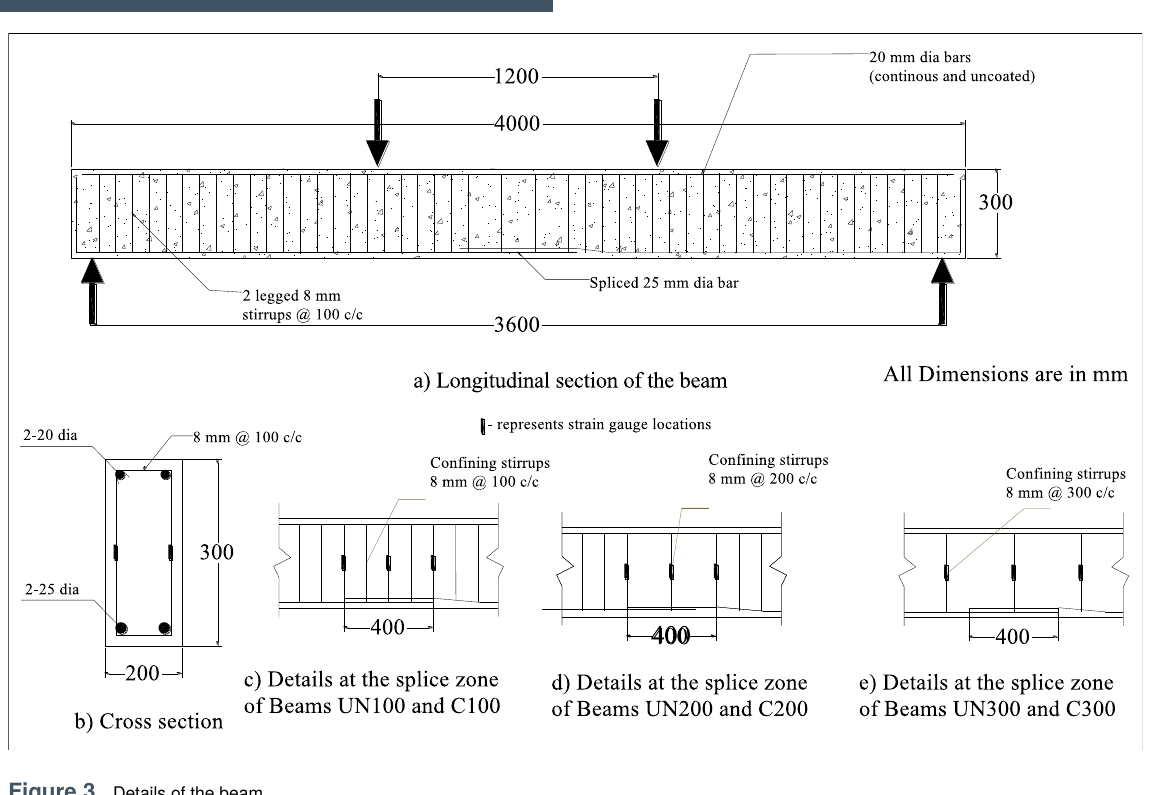
Figure 3. Details of the